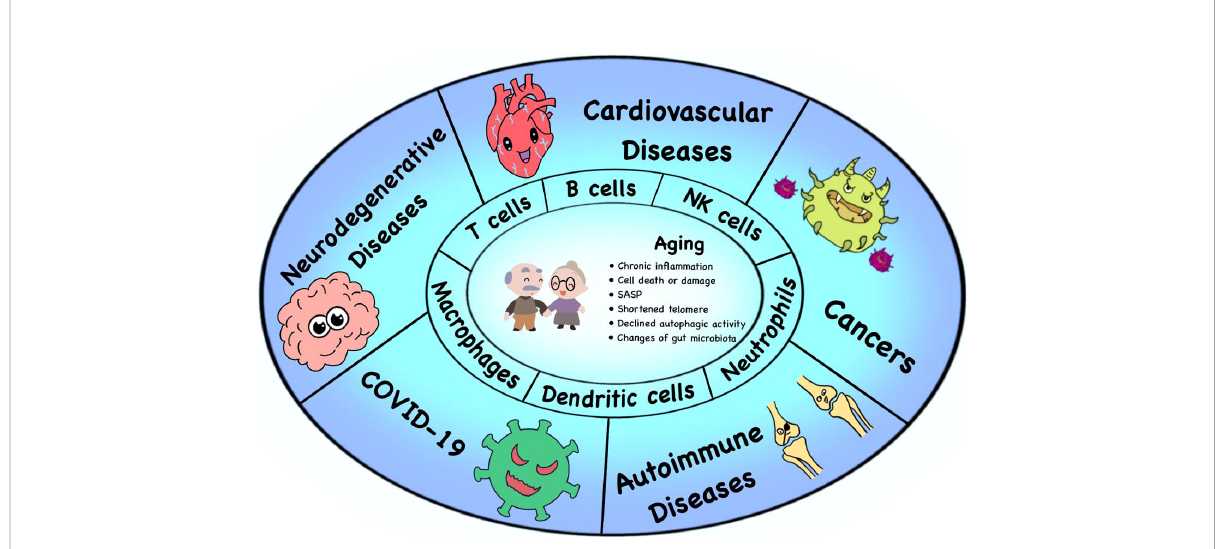
FIGURE 1 Immunosenescence and age-related diseases. Many factors lead to immunosenescence, including the accumulation of SASP, chronic in fl ammation, changes of gut microbiota, shortened telomere and declined autophagic activity. The process of immunosenescence causes a series of changes in immune cell subsets (especially T cells, B cells, NK cells, DCs, neutrophils and macrophages), thus leading to the occurrence of various age-related diseases, such as neurodegenerative diseases, tumors, cardiovascular diseases, autoimmune diseases and the